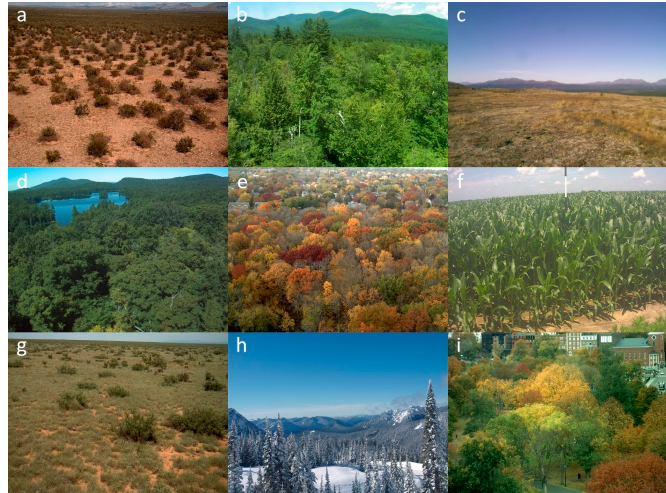
Figure 1. Examples of landscape images as seen by phenology cameras in the PhenoCam network.